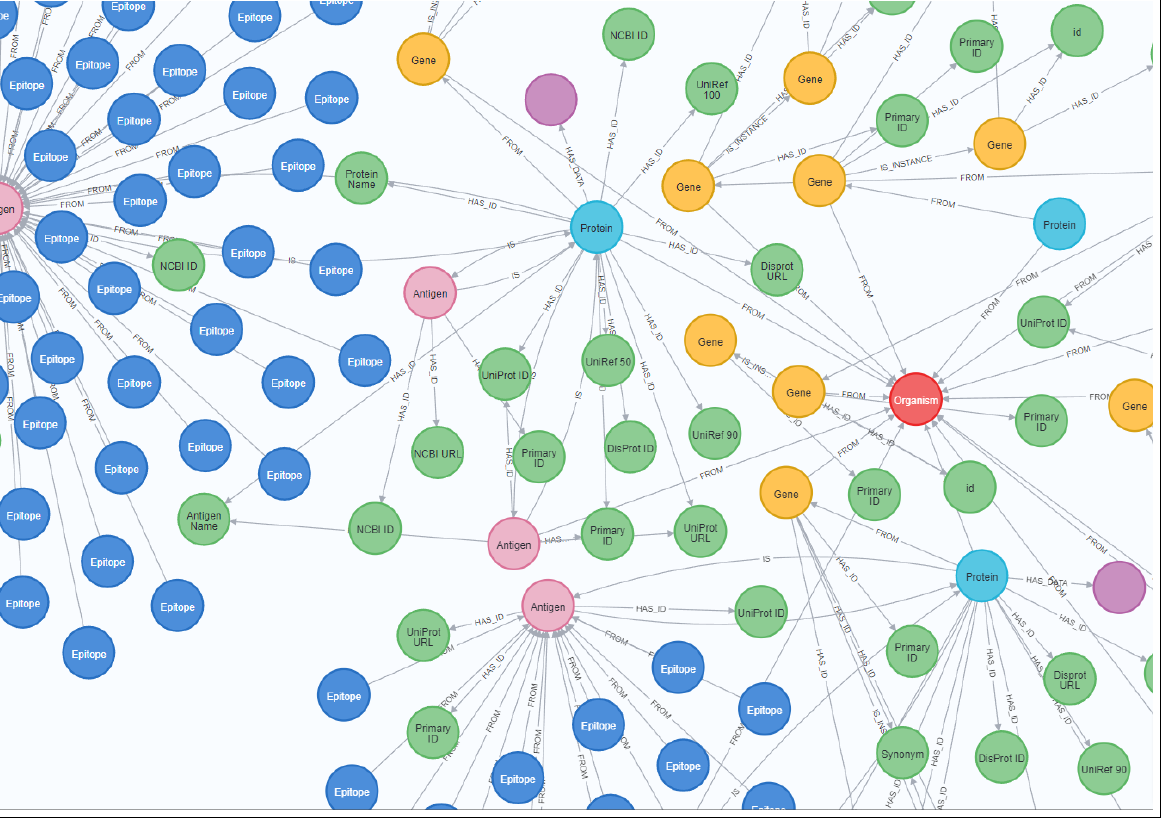
Figure 2. Segment of the knowledge graph constructed from BioGraph model objects and relations extracted from data imported from DisProt [19], DisGeNET [20], Tantigen 2.0 [21], IEDB [22], and HGNC [23] datasets. A red node represents an organism entity, green nodes represent identifiers, purple nodes represent data objects, yellow nodes represent gene entities, cyan nodes represent proteins, pink nodes represent antigen entities, and blue nodes represent